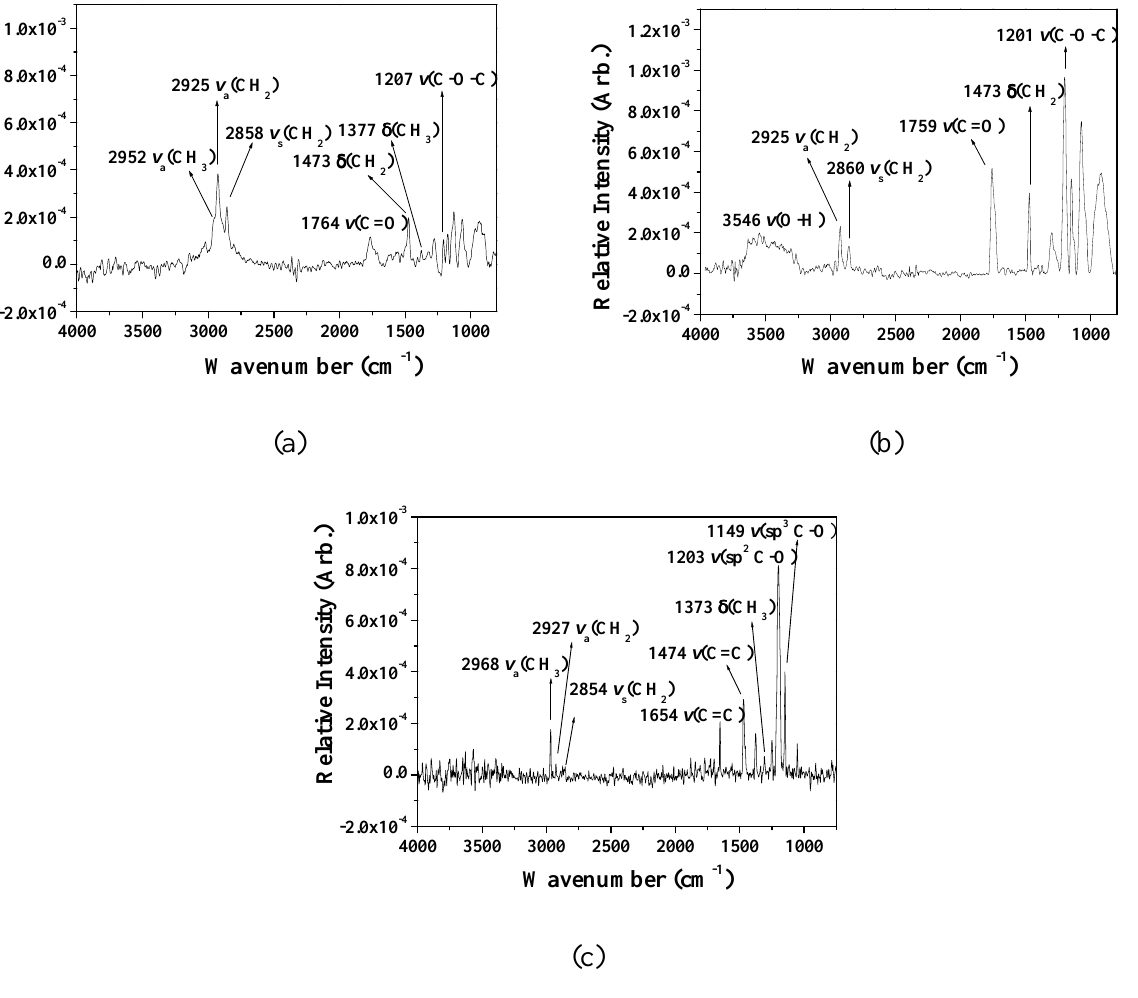
Figure 5 . FTIR-RAS spectra of (a) Cal-4 derivative 1 SAM, (b) Cal-4 derivative 2 SAM, and (c) Cal- 4 derivative 3 SAM on Au